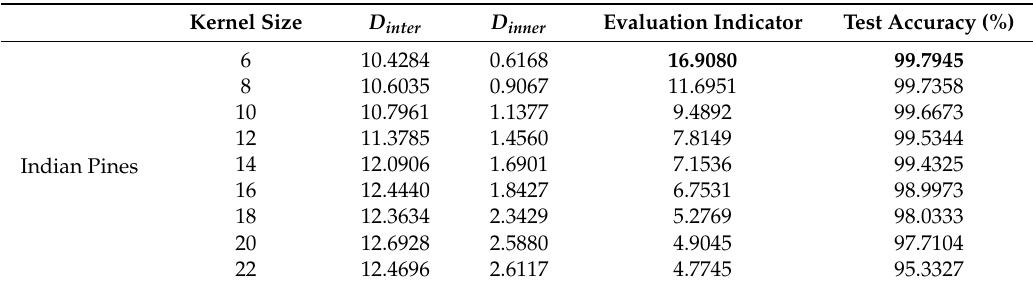
Table 3. The evaluation indicator value and the testing accuracy of K-means Net with different kernel sizes on Dataset 1. Kernel Size D inter D inner Evaluation